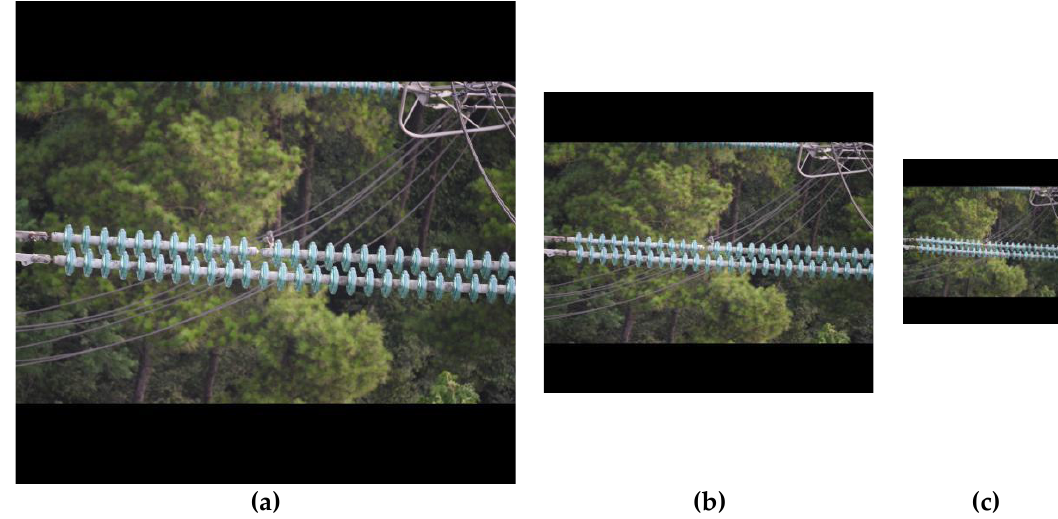
Figure 22. Examples of high, medium and low resolution images. ( a ) High. ( b ) Medium. ( c )